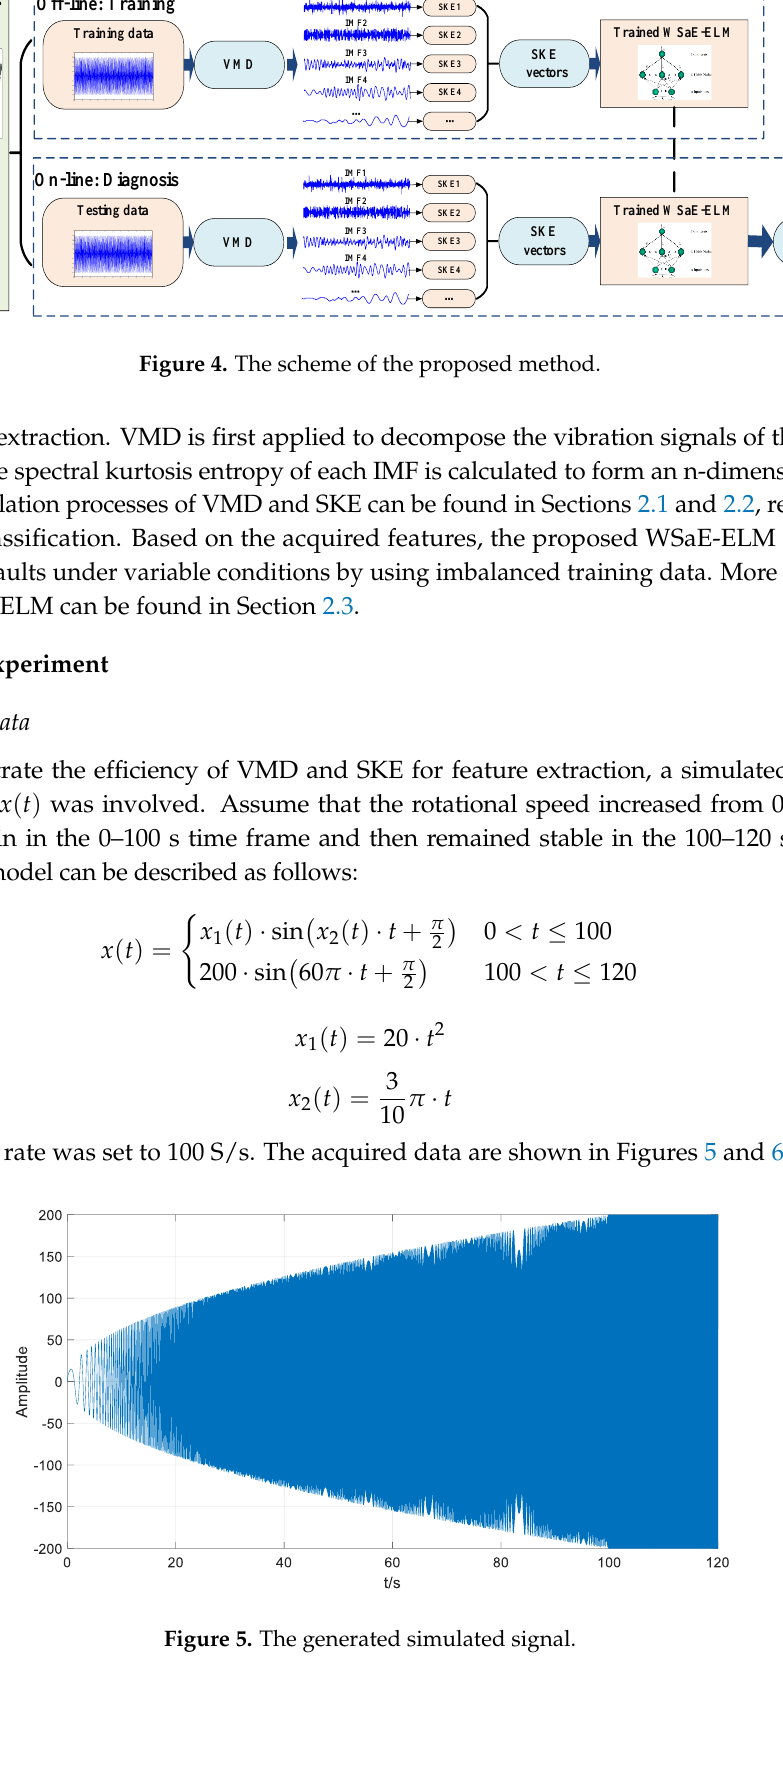
Figure 6. The frequency-domain result of the simulated signal. 3.2. Simulation Result by Using VMD After the generation of the simulated signal, VMD was employed to decompose the signal into four IMFs, as shown in Figure 7. For comparison, IMFs by EMD were also calculated, as shown in Figure 8. It is obvious that the IMFs obtained by EMD are chaotic and cannot accurately represent the characteristics of the signal under different operating conditions. On the contrary, each IMF obtained by VMD is able to precisely represent the information of the signal in a certain stage. 1